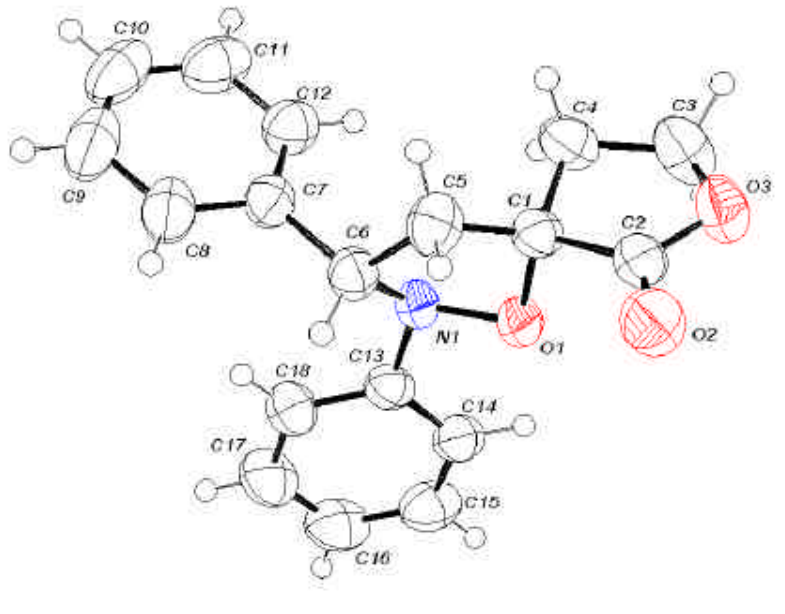
Figure 4. ORTEP view of the major isomer 3a